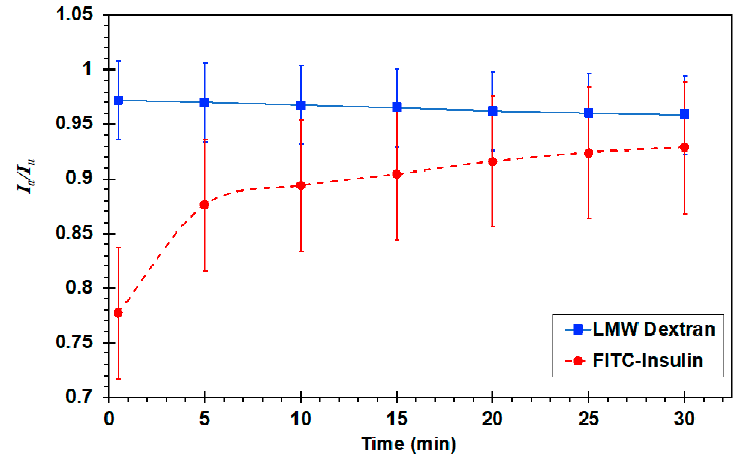
Figure 9. Plot of fluorescent intensity in an air–liquid agitated solution as a function of time. Final intensity refers to the solution intensity at time t = 30 min. Normalize by the intensity of un-agitated solutions, I a / I u .